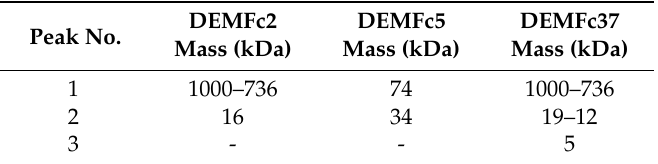
Table 2. Molecular weight distributions of proteolysed EPS (P) obtained from cultures of three F. culmorum strains. Peak